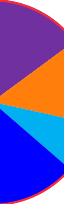
FIG. 6. The trivial, single community containing all stocks of the S&P 500 (log-returns of daily closing prices from 2001Q4 to 2011Q3), obtained by either naively treating the correlation matrix as a weighted network and using the ordinary network- based modularity or, alternatively, using the correlation-based modularity Q 1 ð ~ σ Þ (i.e., without filtering the correlation matrix). In both cases, the Louvain algorithm (see the Appendix) has been used. The colors represent different GICS sectors (color legend in Table I) and span an area proportional to the number of stocks in each sector.